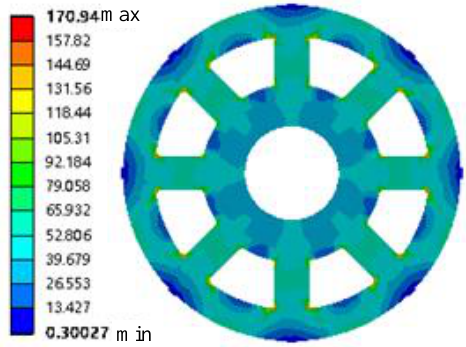
Figure 18. Stress distribution diagram of the rotor runaway condition.